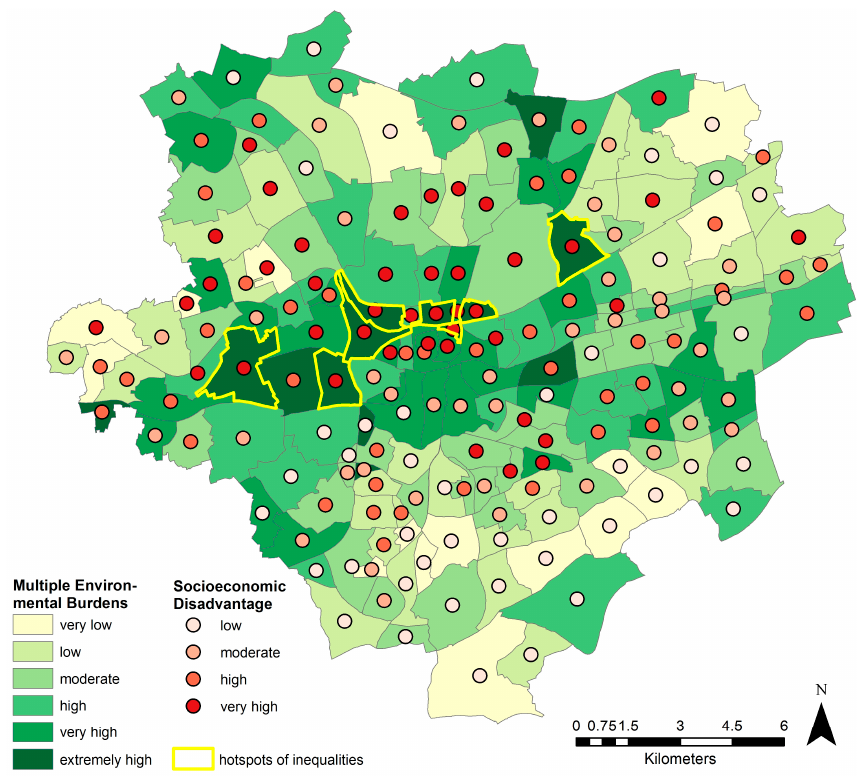
Figure 6. Hotspots of socioeconomically-driven environmental health inequalities: multiple environmental burdens and the proportion of socioeconomically-disadvantaged residents per neighborhood.